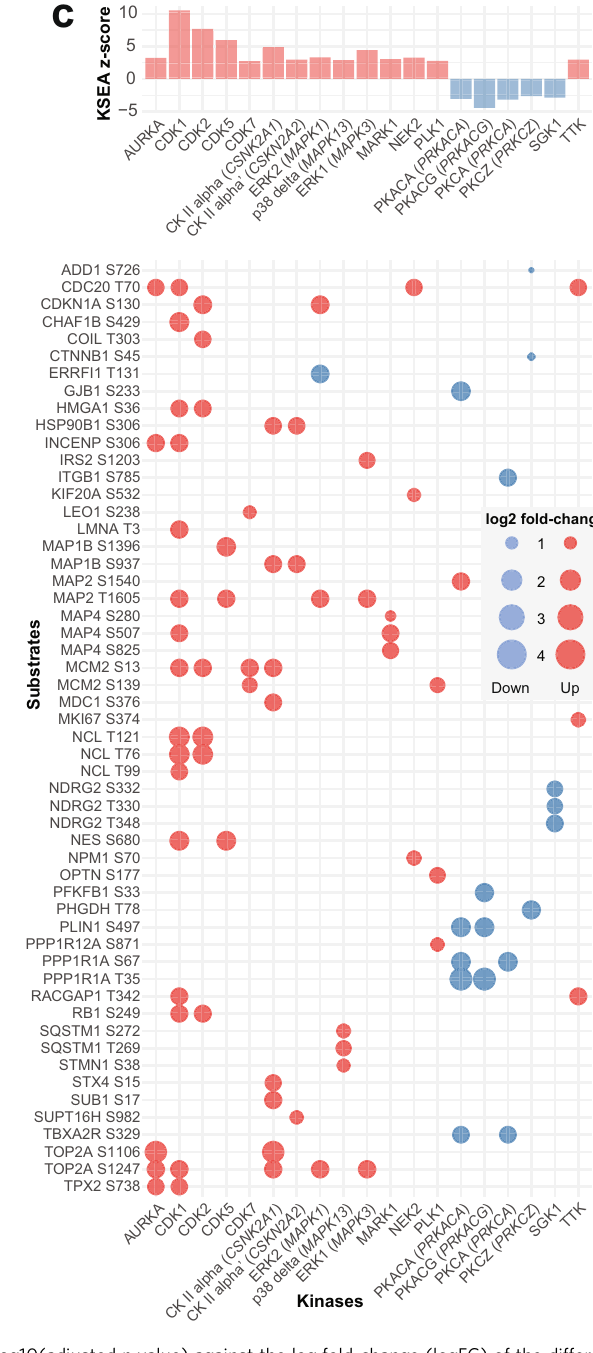
Fig. 3 The phosphoproteomic landscape of HCC. a Volcano plot of the − log10(adjusted p value) against the log fold-change (logFC) of the differentially regulated phosphorylation sites in HCC compared to normal livers. Dots are colored by logFC. Vertical dotted lines indicate |logFC| = 2 and horizontal dotted line indicates adjusted p value = 0.05. b Dot plot illustrating selected enriched Reactome pathways according to gene set enrichment analysis (GSEA) from the differential expression analysis in ( a ). NES normalized enrichment score. c Top barplot showing the enrichment z-score of the kinases with signi fi cantly up- or downregulated kinase activity in a kinase-substrate enrichment analysis (KSEA) comparing HCC to normal livers. In the bubble plot below, the phosphorylation site substrates are shown in rows, where red and blue dots indicate that the phosphorylation site is up- and downregulated, respectively. The size of the dots is proportional to the log2fold-change of the phosphorylation site. Phosphorylation sites with at least a 5-fold difference between HCCs and normal livers are shown. For kinases with <3 substrates with at least a 5-fold difference, the top three substrates with the highest |logFC| are shown. Source data are provided as a Source Data fi mRNA or the protein levels, while CTNNB1 mutations were associated with increased expression (Supplementary Fig. 11). Fig. 10 and Supplementary Data 10). An analysis of the SMGs on To evaluate the molecular changes associated with CTNNB1 their cognate mRNA and protein products revealed that APOB and TP53 mutations, we performed differential expression and TP53 mutations were associated with lower expression on the